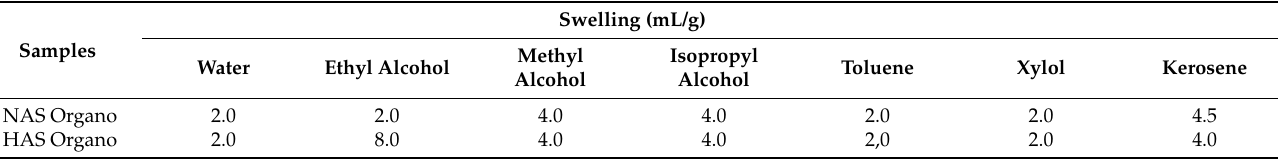
Table 3. Swelling values of organophilic clays after stirring.